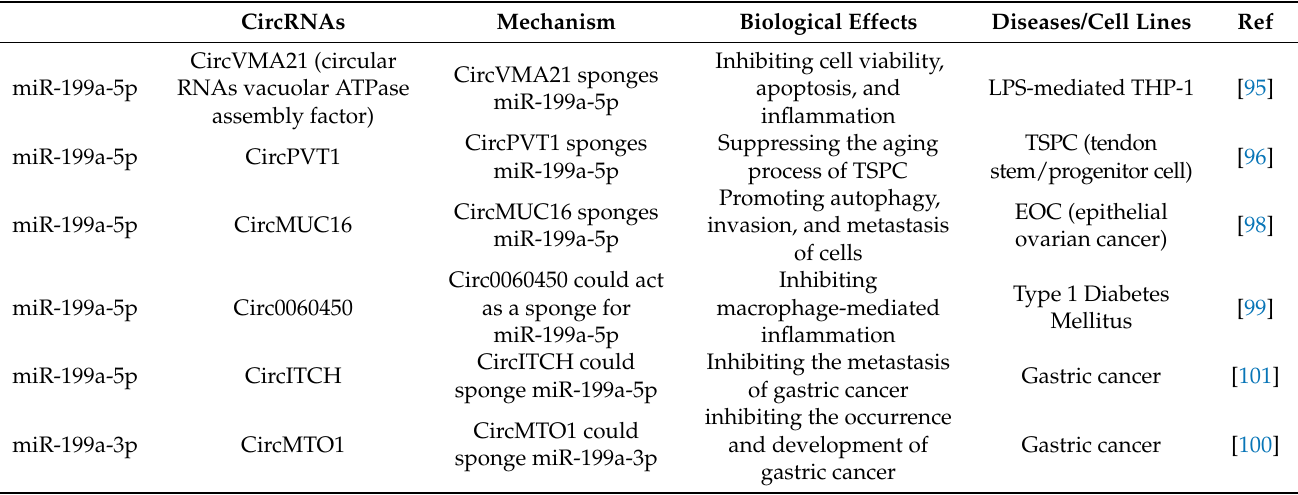
Table 5. Interplay between miR-199a and